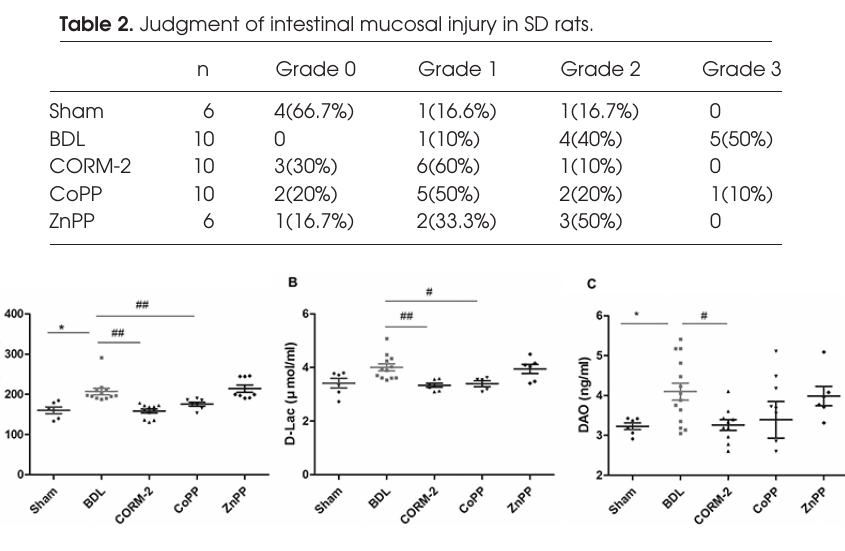
Figure 1. ELISA assay for markers of intestinal injury in control (Sham) and BDL rats in the absence or presence of HO-1 activators. (A) serum endotoxin; (B) serum D-Lac; (C) serum DAO. Serum endotoxin, D-Lac and DAO were significantly increased in the BDL group compared with the Sham group, * P < 0.05. CORM-2 or CoPP treatment decreased the levels of endotoxin and D-Lac, # P < 0.05, ## P < 0.01 compared with the BDL